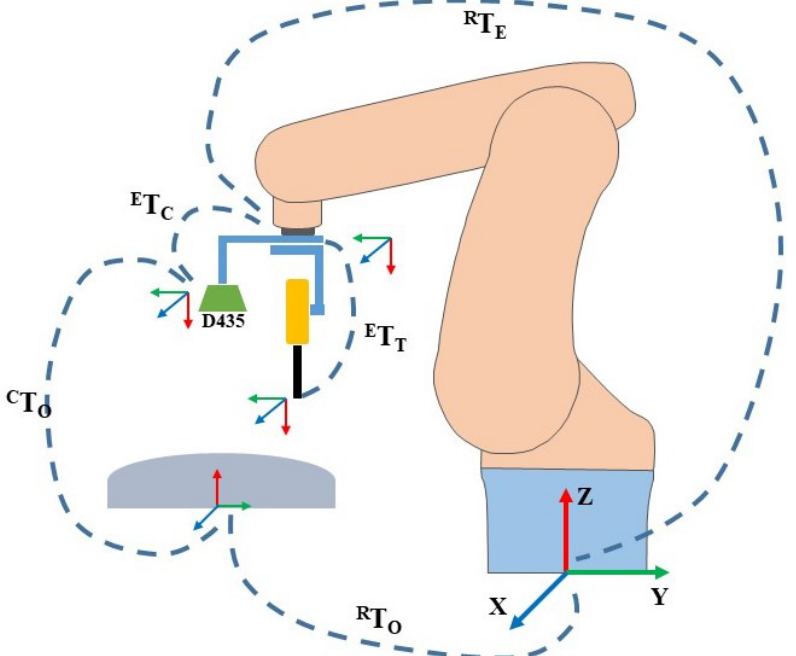
Figure 2. Overall transformation matrices used in the proposed scheme. Where the term R T O is object-to-robot transformation. R T E represents the transformation from the robot to the end-effector, E T C is the transformation from the end-effector to the camera, and transformations. E T C sets the camera’s relative position and rotation in relation to the robot’s pose, and R T E is the current position of the end-effector relative to the robot’s base coordinate. RealSense D435 is the stero camera employed.